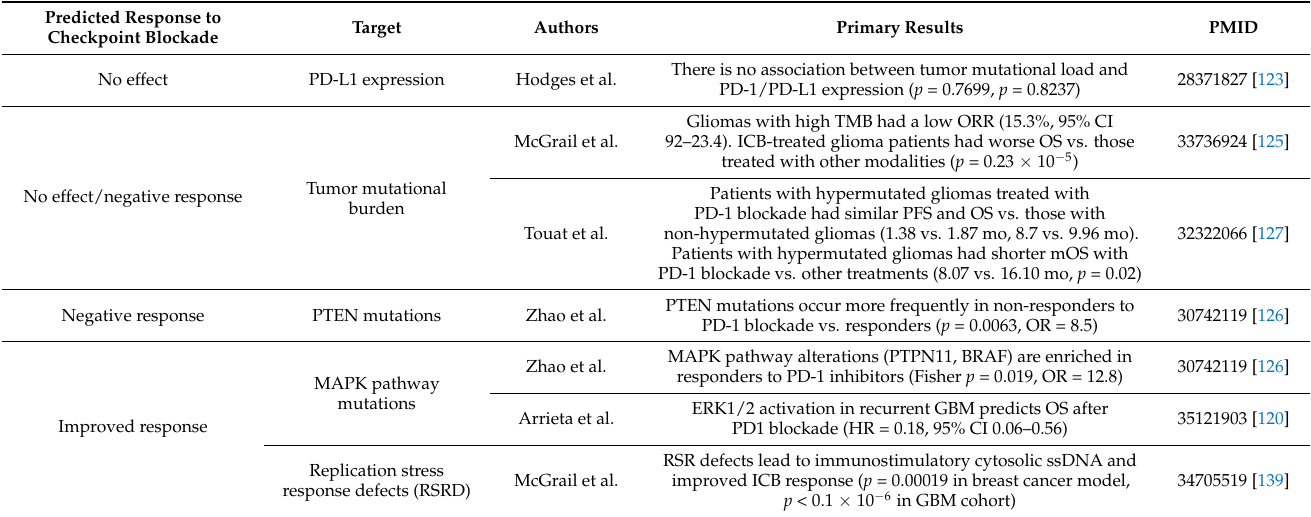
Table 5. Studies investigating factors affecting checkpoint inhibitor response in